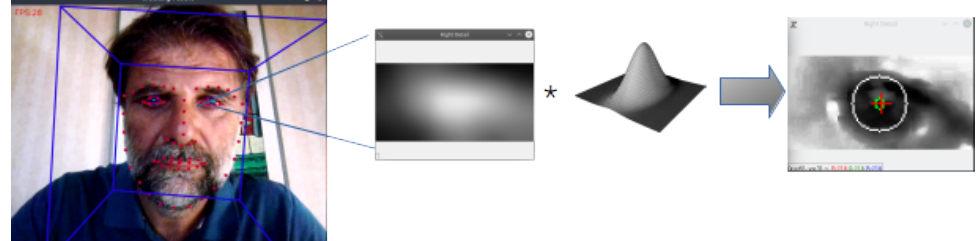
Figure 3. An illustration of the eye-tracking algorithm adopted (see